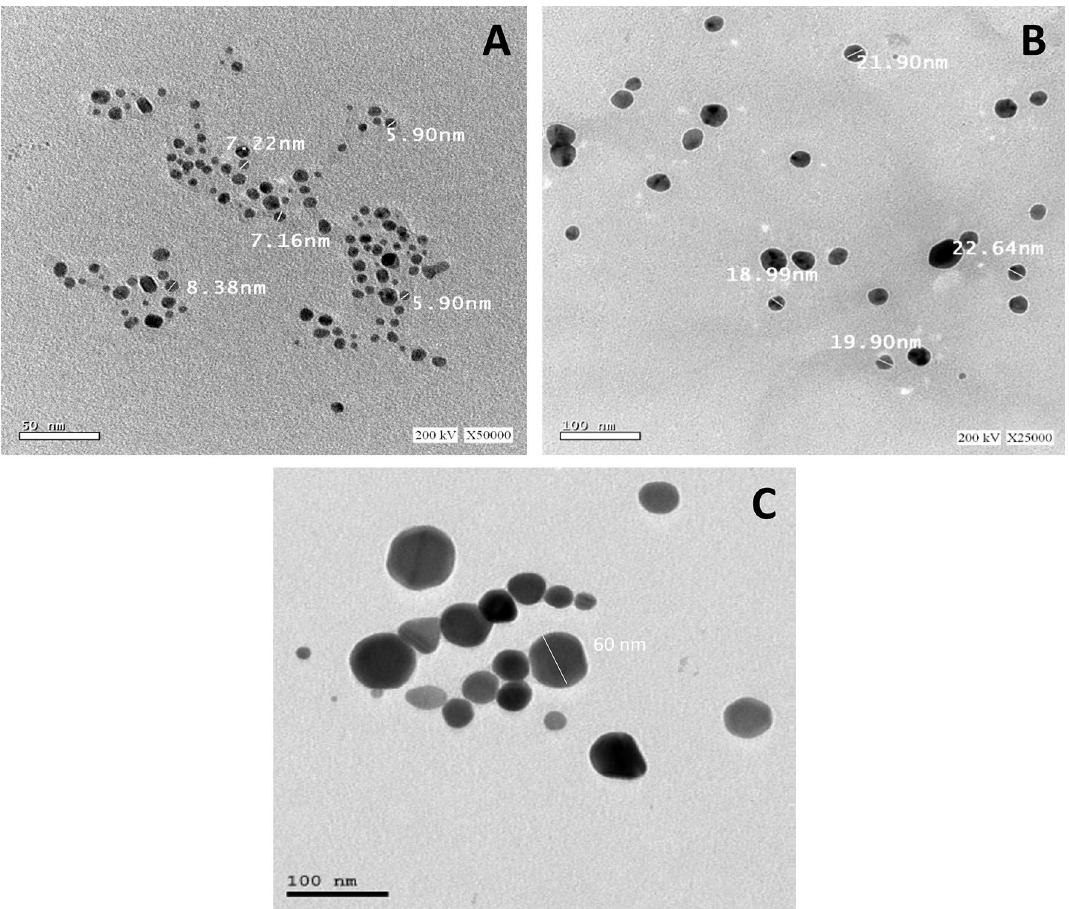
Figure 7. TEM analyses of synthesized AgNPs ( a ) TEM micrograph of cinnamon AgNPs, ( b ) TEM micrograph of ginger AgNPs and ( c ) TEM micrograph of chemical AgNPs.